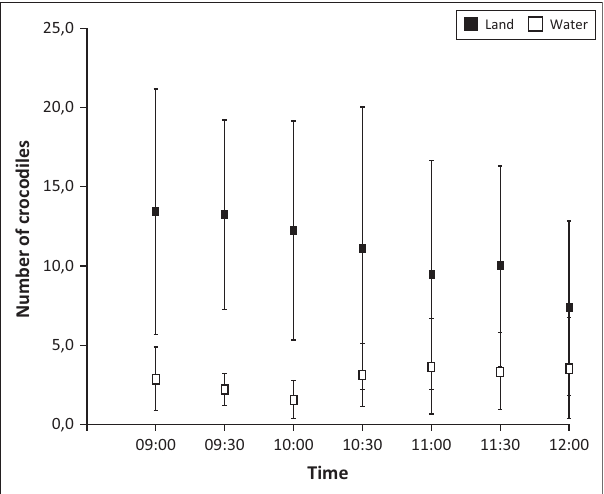
FIGURE 2: Individual counts at half-hourly intervals of four sampling events, during 12 days, of crocodiles seen on land and in the water in and around Sunset Dam at Lower Sabie, Kruger National Park.